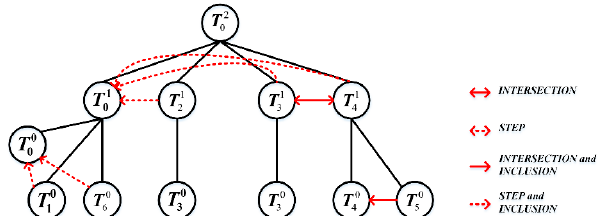
Figure 4. Labeling the relationship between the pair of two adjacent segments from each level of the generated topological relationship graph (TRG), and two adjacent segments should be from the same father node. When two adjacent segments are from different father nodes, the relationship is not labeled, and it could be derived from their father nodes.